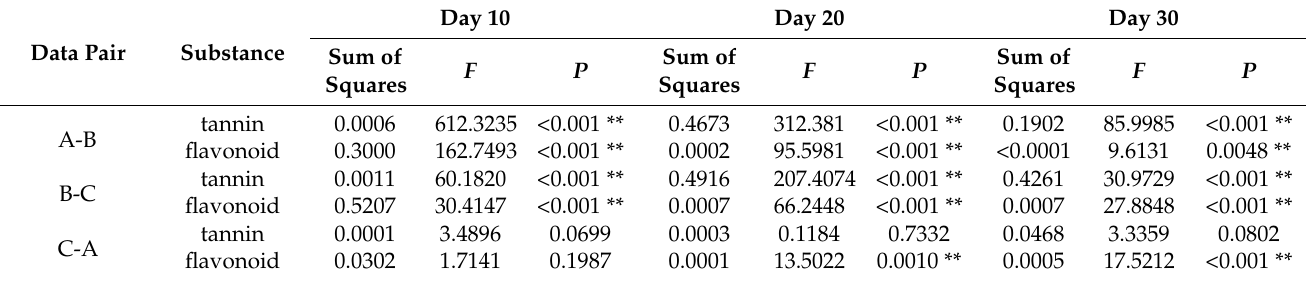
Figure 6. Change in defence substances after oviposition of R. foveipennis : ( A ) change in tannin content; ( B ) change of flavonoid content on days 10, 20, and 30 in treatments A, B, and C in 2013. Y-axes do not start from zero. Five (pear) replicates from each treatment at each time; vertical bars are standard deviations. Table 1. The ANOVA analysis for content differences of tannin and flavonoid on days 10, 20, and 30 in treatments A, B, and C in 2013.